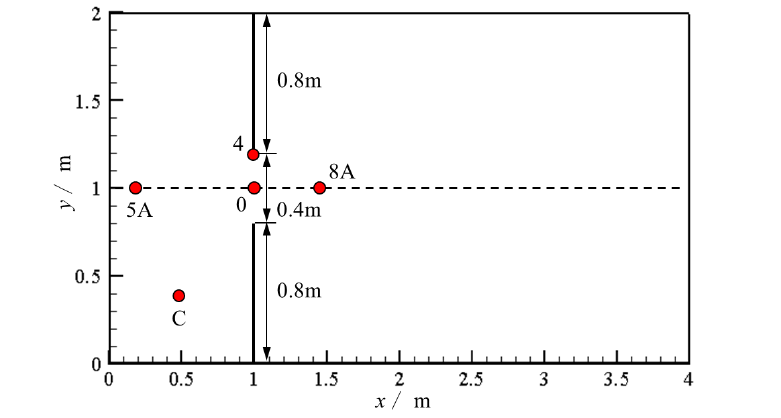
Figure 3. The detailed setup of partial dam break experiment and positions of the gauges [2]. Table 1. Coordinates of gauge stations.